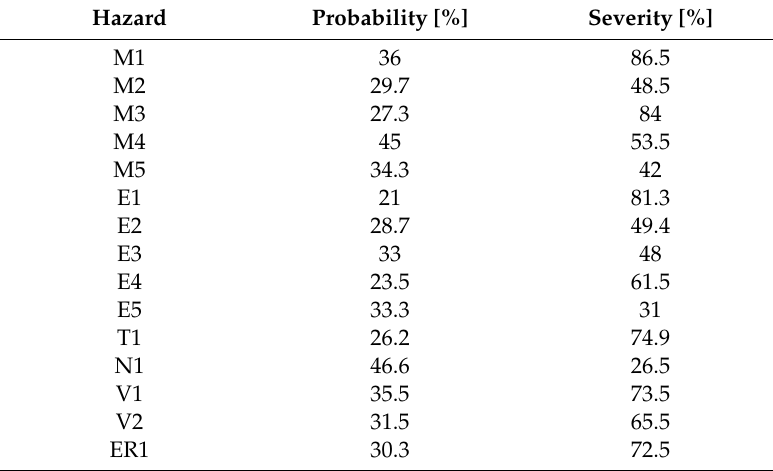
Table 6. Mean values for Severity and Probability [16].